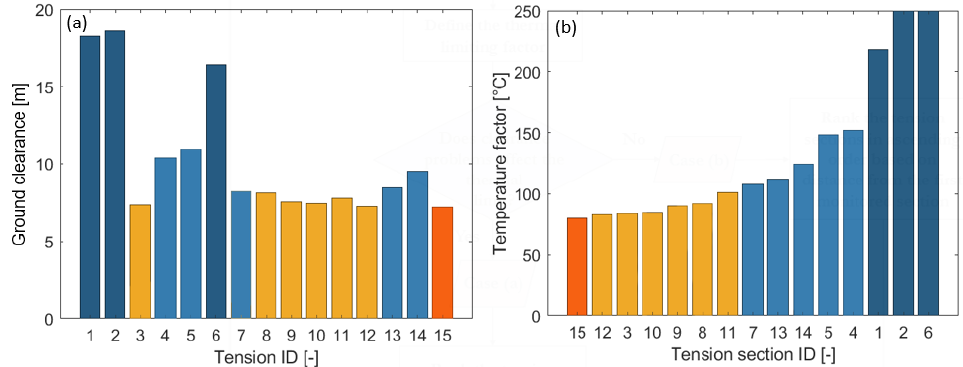
Figure 6. Power line section details: ( a ) ground clearance result of the critical span analysis; ( b ) ranking of the tension section based on the temperature factor [16].